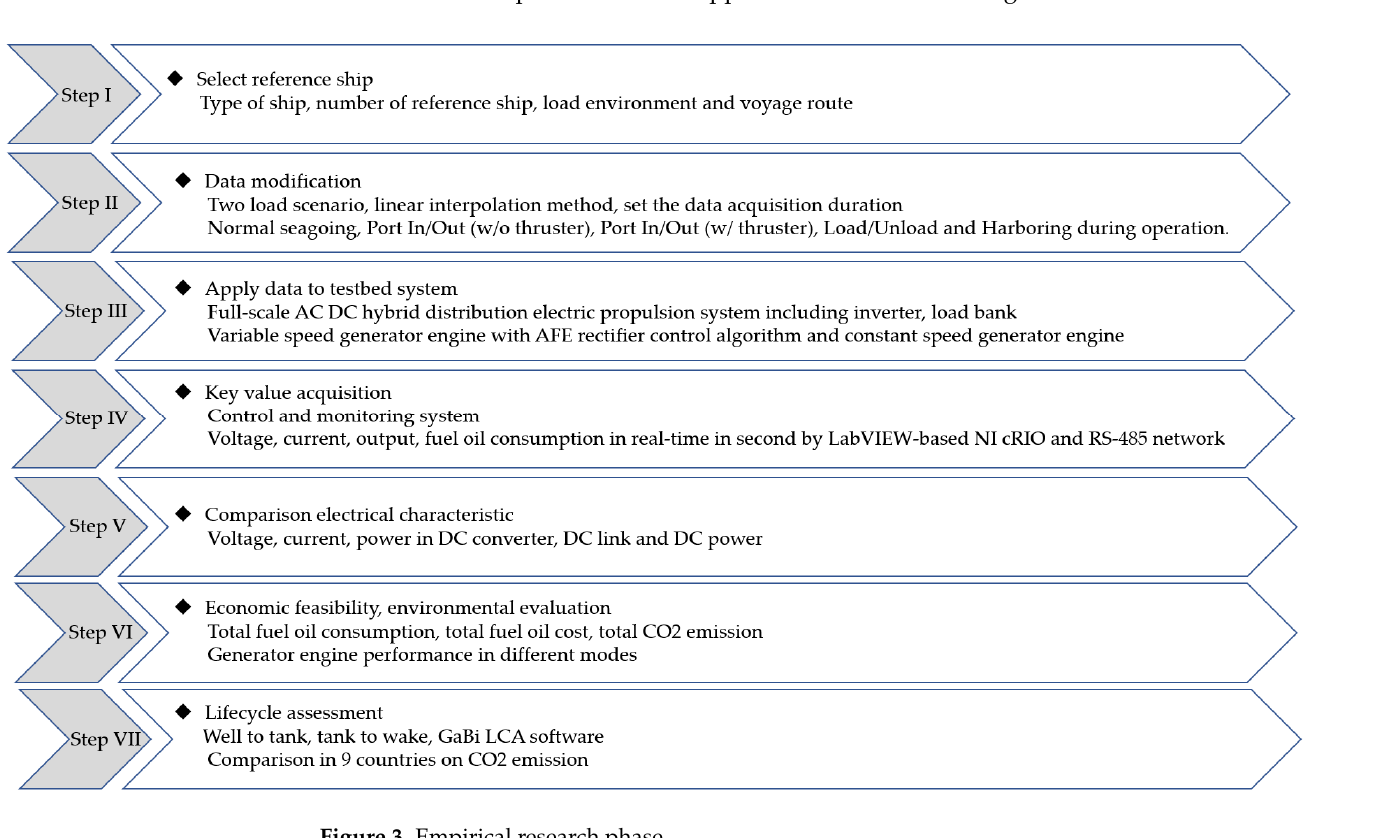
Figure 3. Empirical research phase.